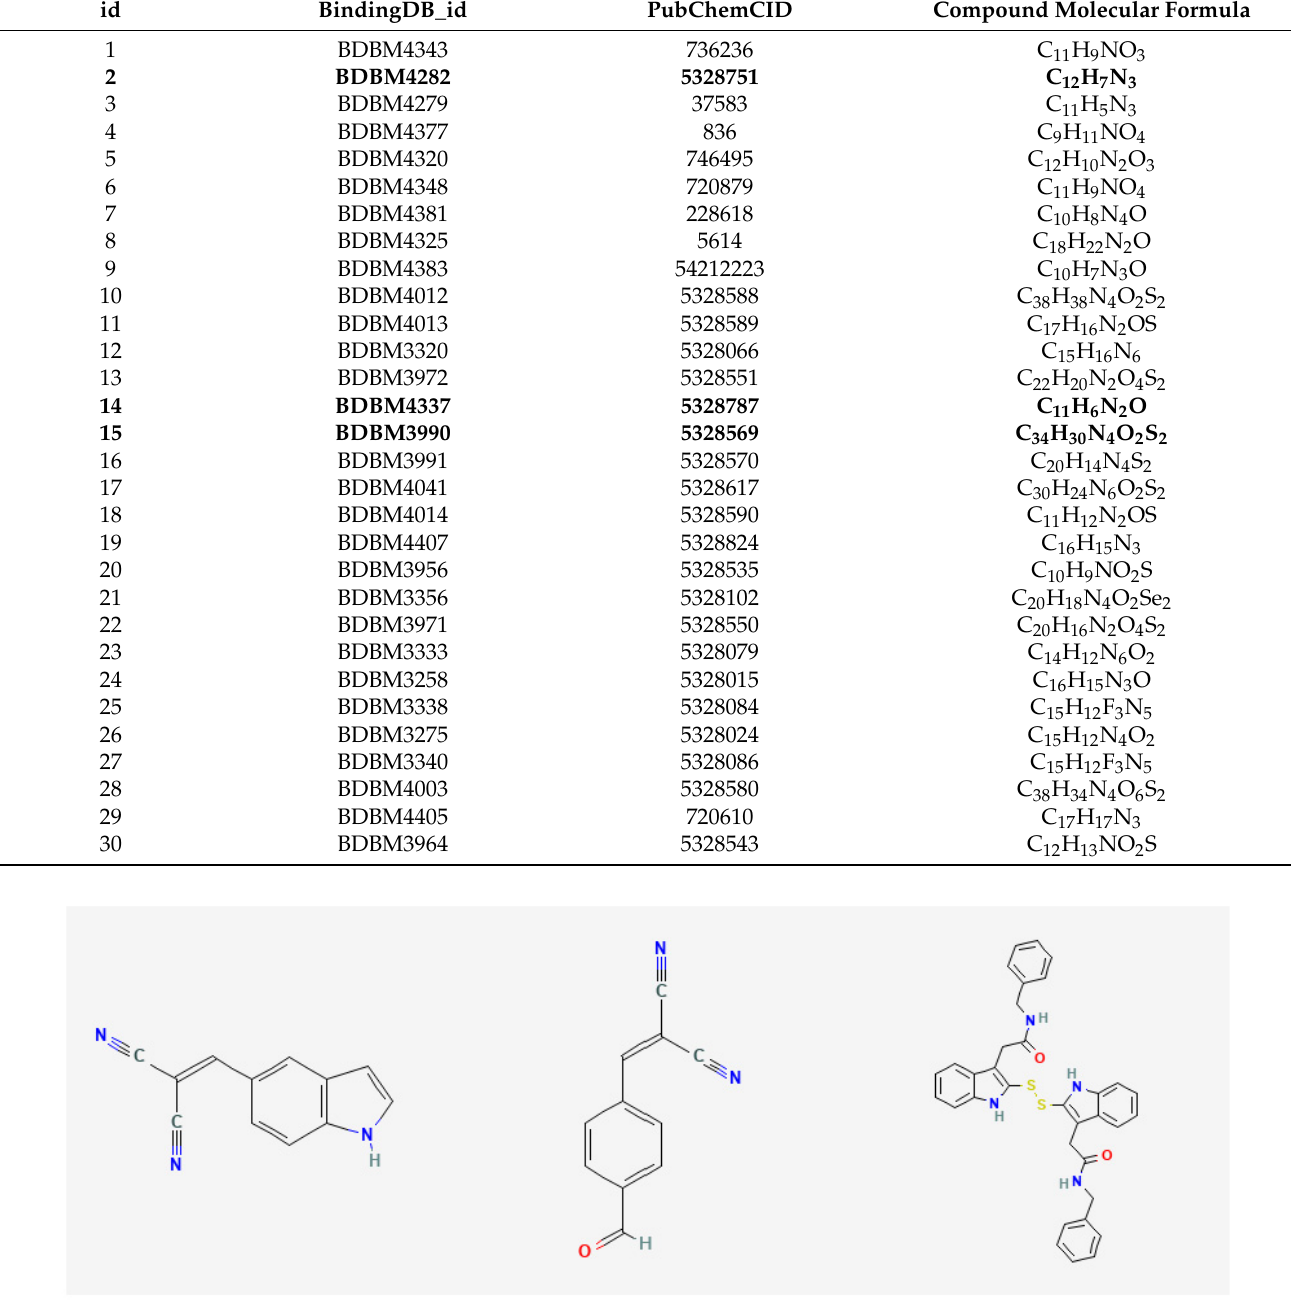
Figure 2. A 2D molecular diagram of the top three compounds.